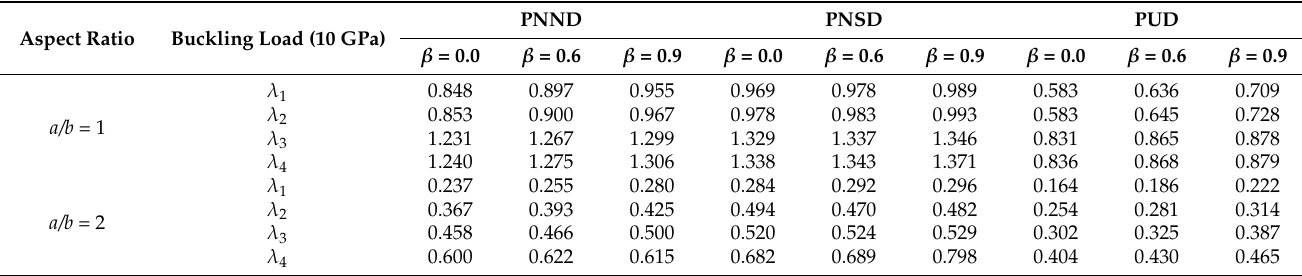
Table 9. First four shear buckling loads for a CFCF FG-saturated porous plate with different aspect ratios, a / b , porosity distributions and Skempton coefficients, β , while keeping e 0 = 0.6 fixed. Aspect Ratio